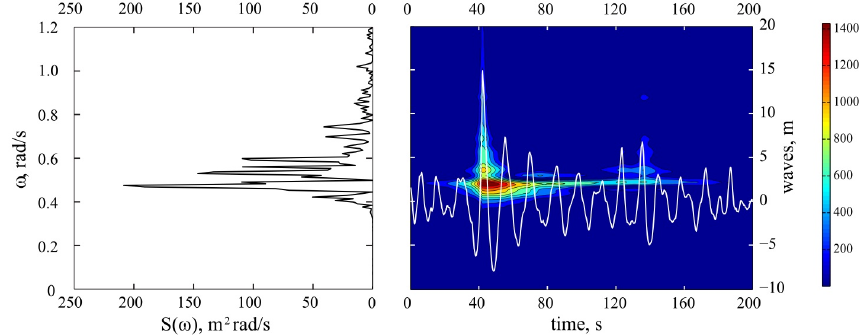
Figure 2. Time–frequency spectrum of group I containing the freak wave.